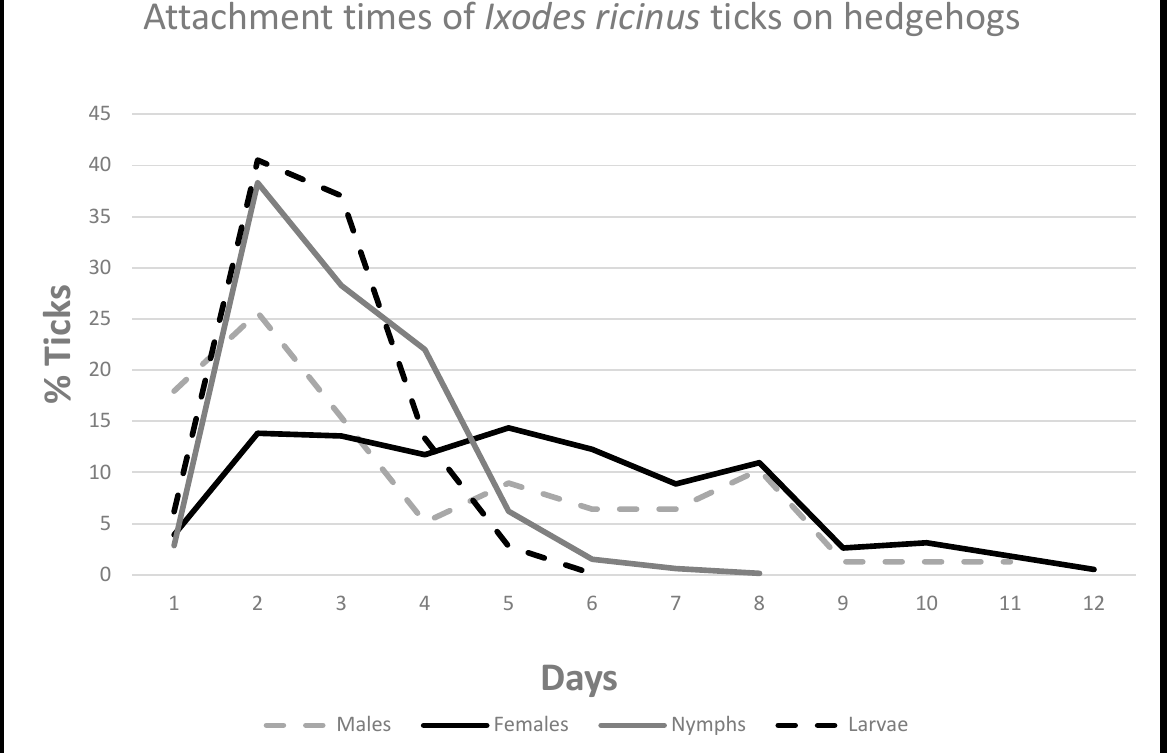
Figure 1. A tt achment times of Ixodes ricinus ticks on hedgehogs.